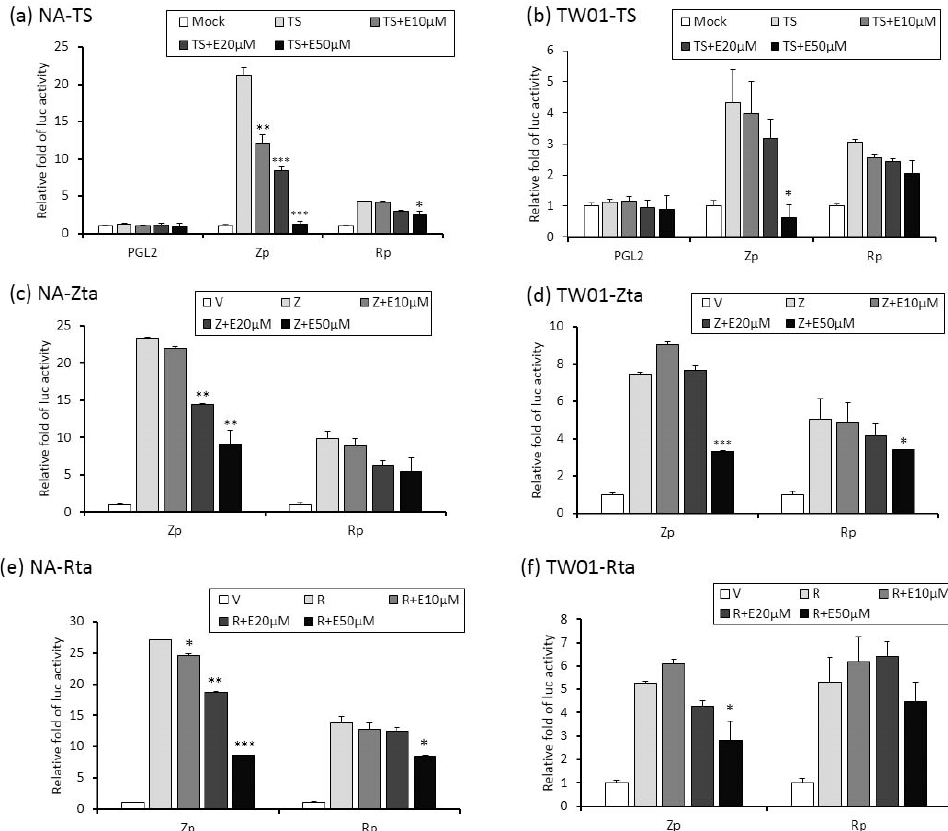
Figure 5. The activities of Zp and Rp are repressed by emodin treatment of NA cells. ( a , b ) NA and its parental EBV negative cell line, TW01, were transfected with luciferase reporters containing Zp or Rp, followed by emodin (E) and TPA + SB (TS) treatments. After TS induction for 24 h, cell lysates were collected for measurement of luciferase activity. Data are means ± SD from at least two independent experiments. ( c , d ) Zta-expressing plasmid (Z) was co-transfected with Zp or Rp luciferase reporters into NA ( c ) or TW01 ( d ) cells, with same emodin and TPA + SB treatments depicted in ( a , b ). ( e , f ) same to ( c , d ), except Rta-expressing plasmid (R) was used. (* p < 0.05, ** p < 0.01, *** p < 0.001 compared to the groups of TS, Z or R, respectively).